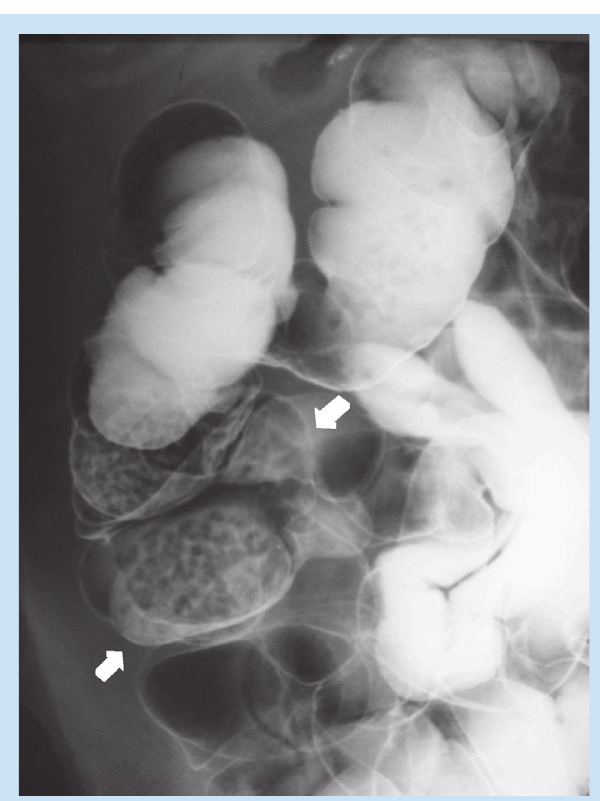
Fig. 3. Chewed cashew nuts (arrows) simulating polyps.Fig. 2c. Mealie pips (arrows)